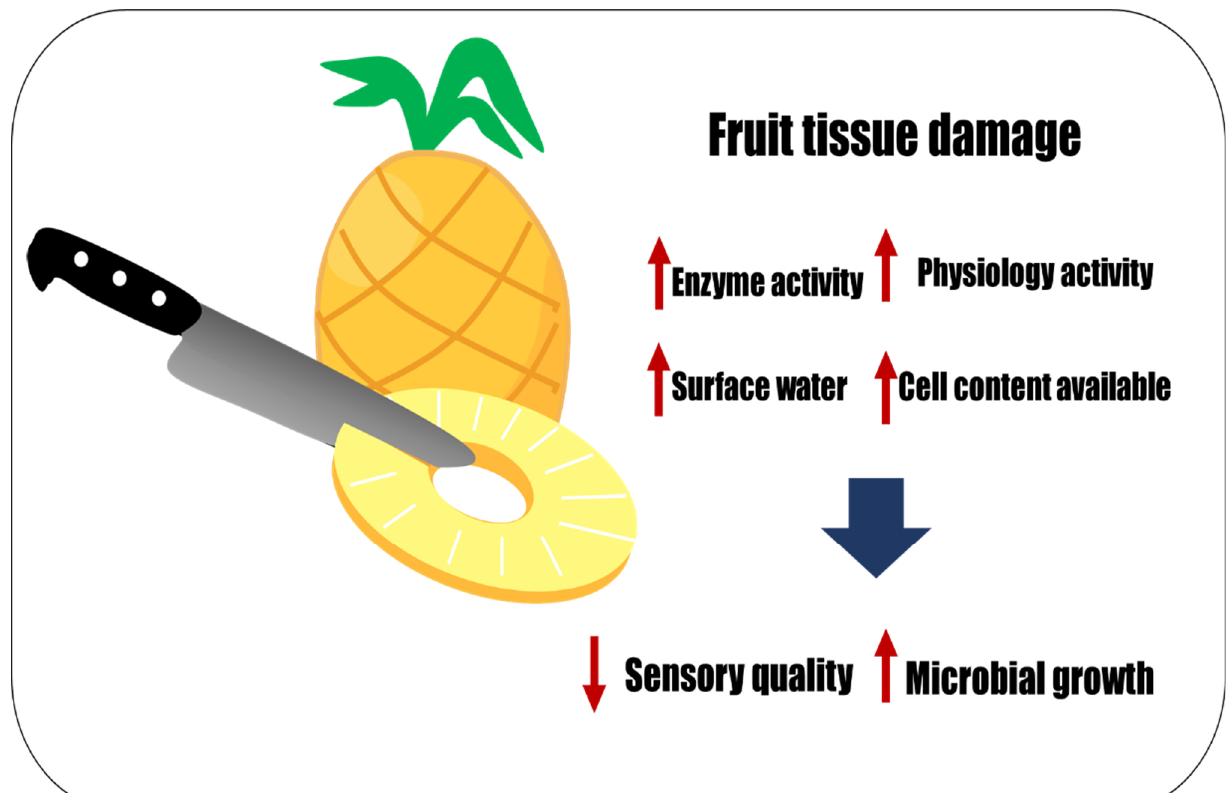
Figure 1. Minimal processing affects sensory quality and promotes microbial growth. The red up arrow indicates increase and the red down arrow indicates decrease.